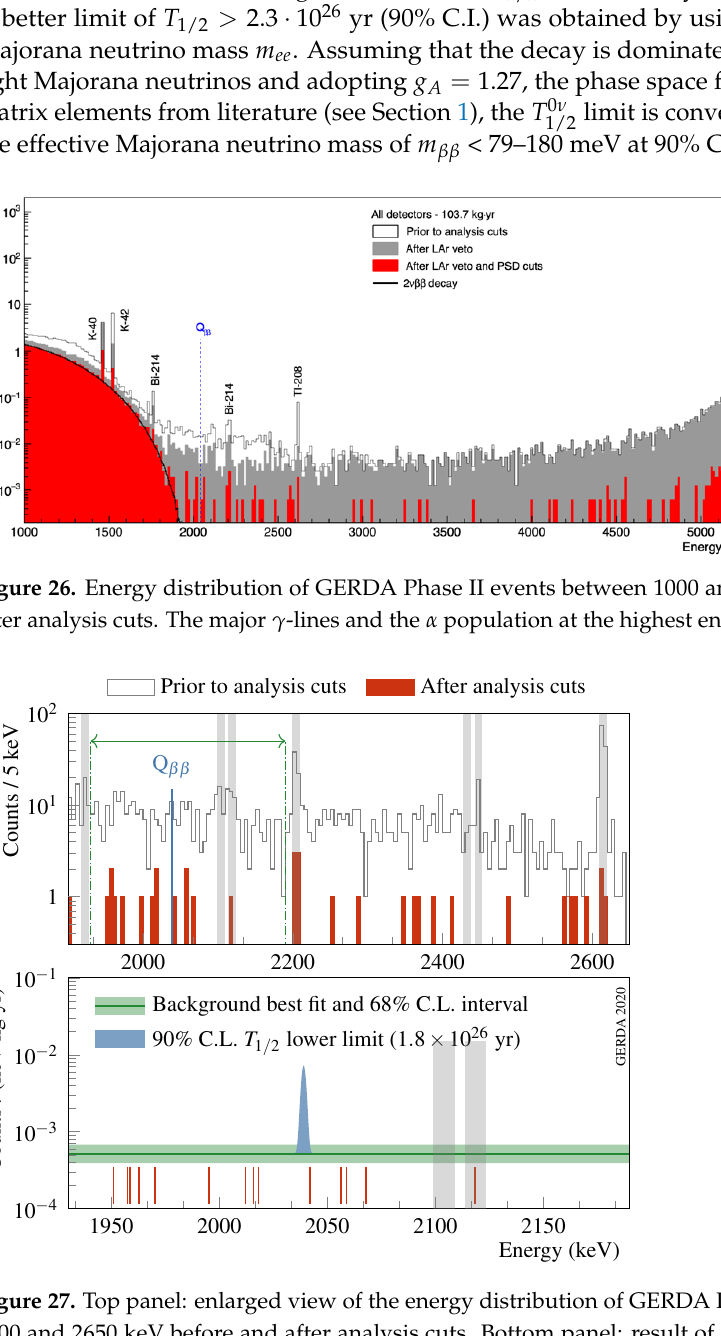
equal to the lower limit 1/2